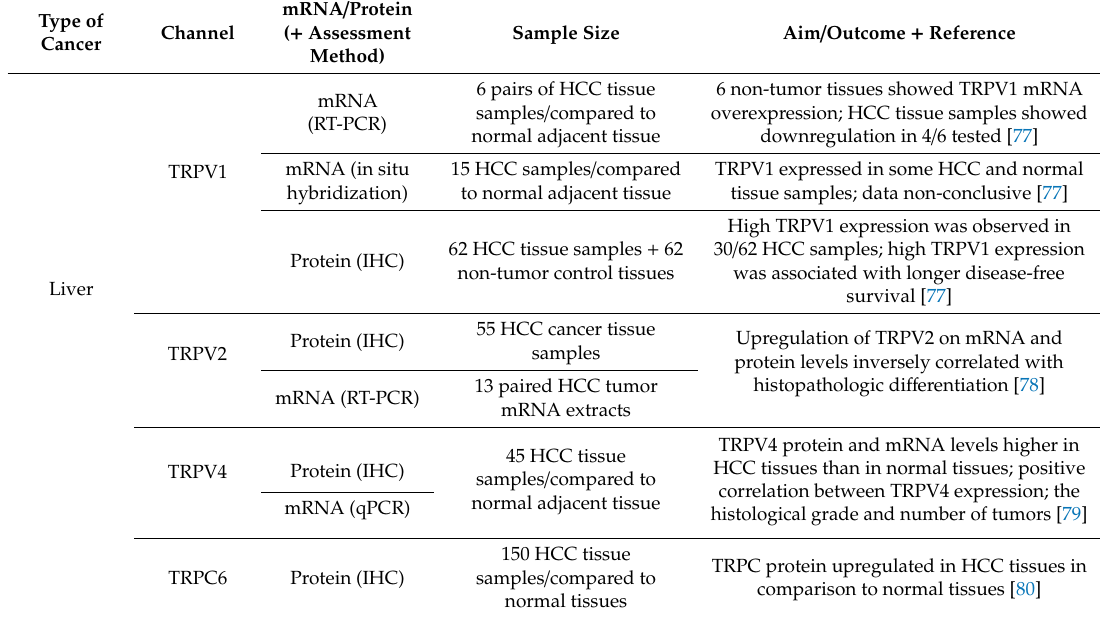
Table 3. Expression of TRP channels in human liver cancer